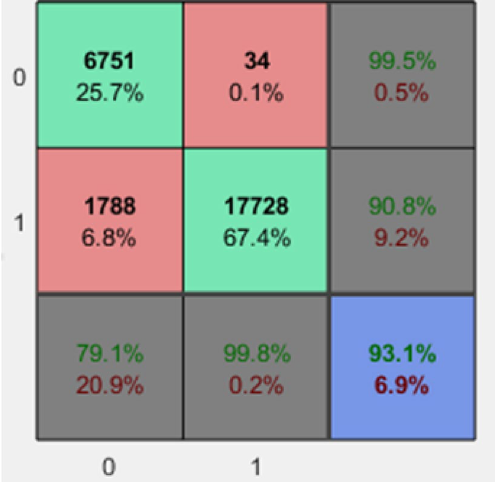
Table 11 Confusion matrix of autoencoder with softmax classifier on UNSW-NB15 dataset